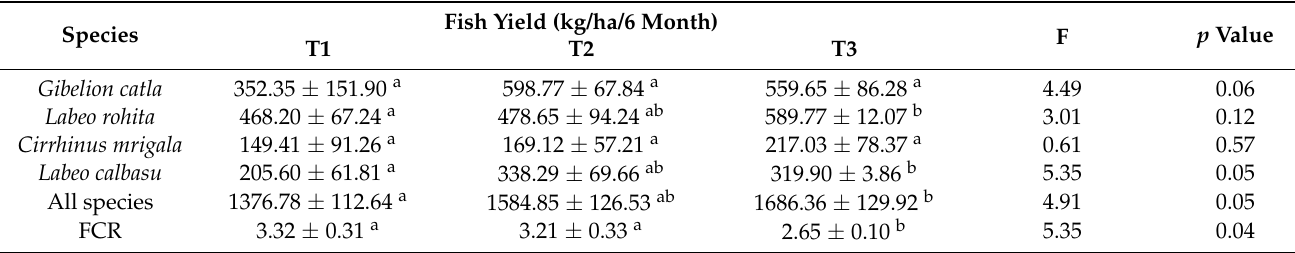
Table 3. Observation of fish yield and FCR in three different